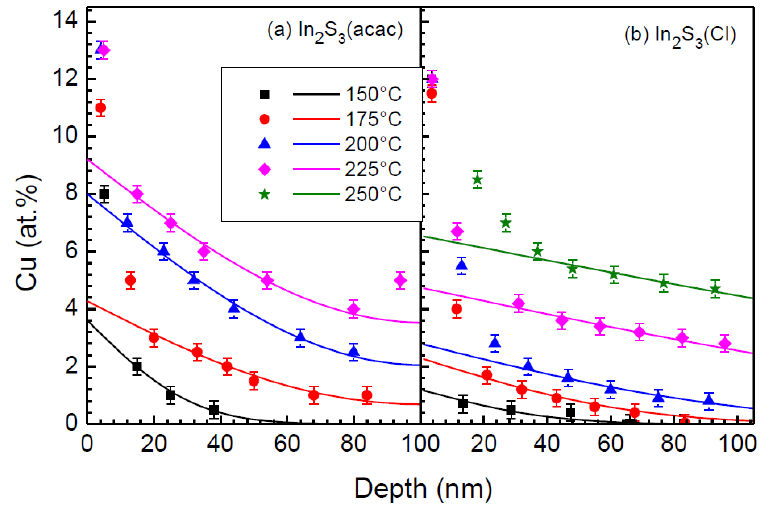
Figure 3. Simulated and measured depth profiles for Cu in ( a ) In 2 S 3 (acac):Cu and ( b ) In 2 S 3 (Cl):Cu from which diffusion coefficients were